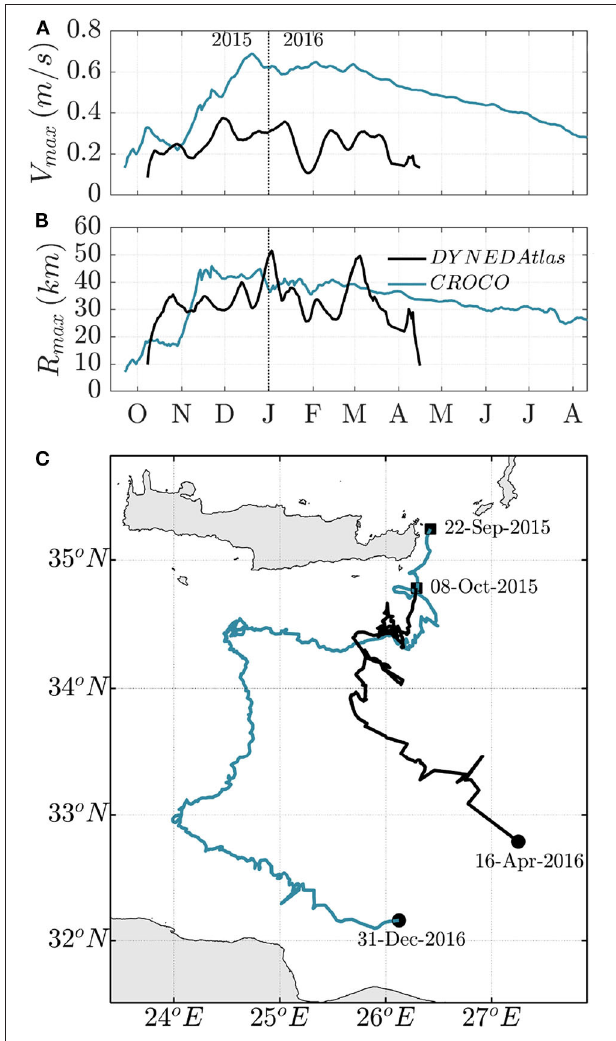
FIGURE 5 | (A) Temporal evolution of long-lived Ierapetra anticyclones as detected in 2015 with AMEDA algorithm from DYNED-Atlas eddy database and from CROCO-MED60v40-2015 simulation. The dynamical characteristics of the eddy velocity V max ( m / s ) and eddy radius R max ( km ) are shown in (A,B) , respectively while their trajectories are illustrated in (C)